Question: Write a single sentence explaining what this figure depicts.
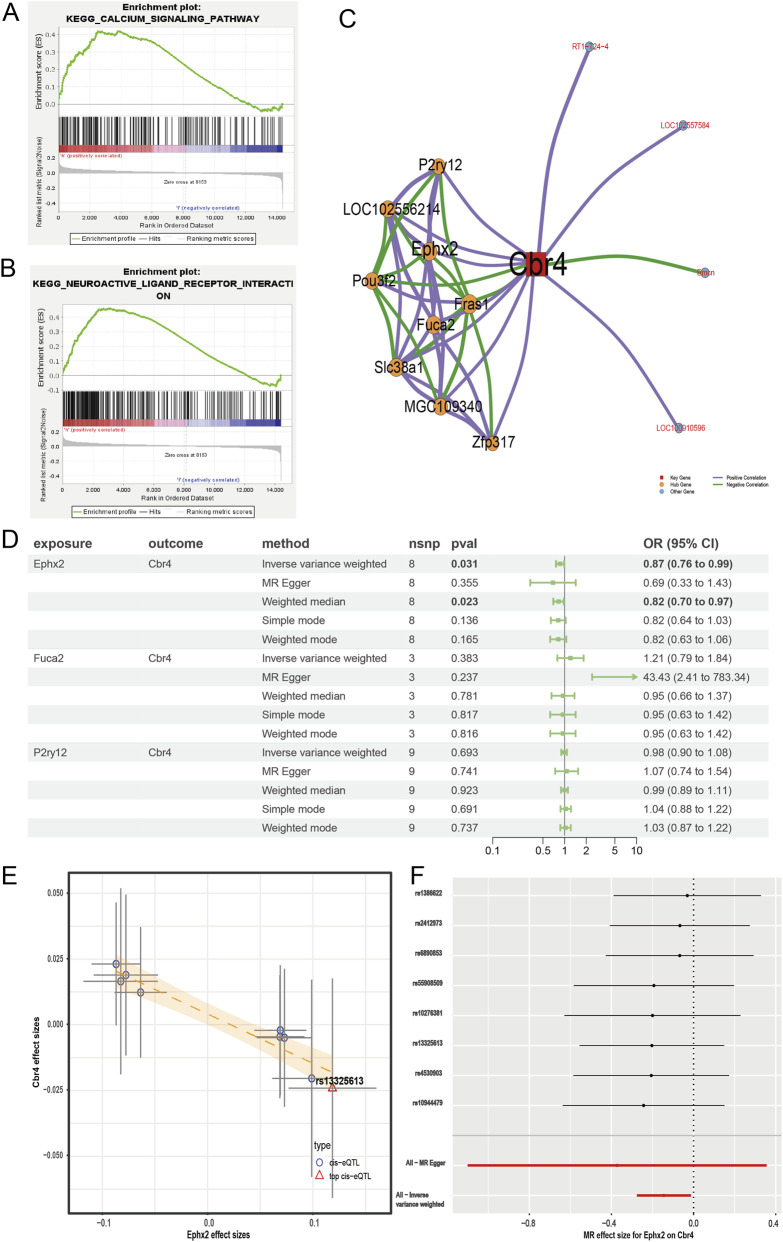
Answer: Functional enrichment, co-expression network, and MR analysis of Cbr4 . (A,B) Key pathways from Gene Set Enrichment Analysis (GSEA) of Cbr4 : (A) calcium ion signaling pathway (NES = 1.50, p = 0.027); (B) neuroactive ligand-receptor interaction pathway (NES = 1.45, p = 0.037). (C) Co-expression network of Cbr4 in the GSE31708 dataset (threshold |r| > 0.6), comprising 14 nodes and 32 edges, with Cbr4 as the central hub. (D) Expression quantitative trait locus (eQTL)-based Mendelian randomization (MR) analysis between genes in the co-expression network and Cbr4 . (E) Scatter plot of eQTL-MR analysis between Ephx2 and Cbr4. (F) Forest plot of single nucleotide polymorphisms (SNPs) from eQTL-MR analysis between Ephx2 and Cbr4 . The plot displays the number of instrumental variables, exposure-outcome factors, and effect size statistics. The inverse variance weighted (IVW) model showed a positive causal effect (OR = 1.32, 95% CI = 1.15–1.51, p = 2.3 × 10 −4 ).